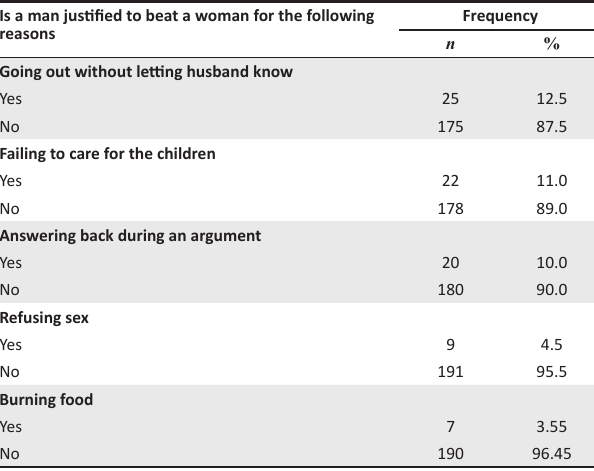
TABLE 3: Attitudes towards intimate partner violence.